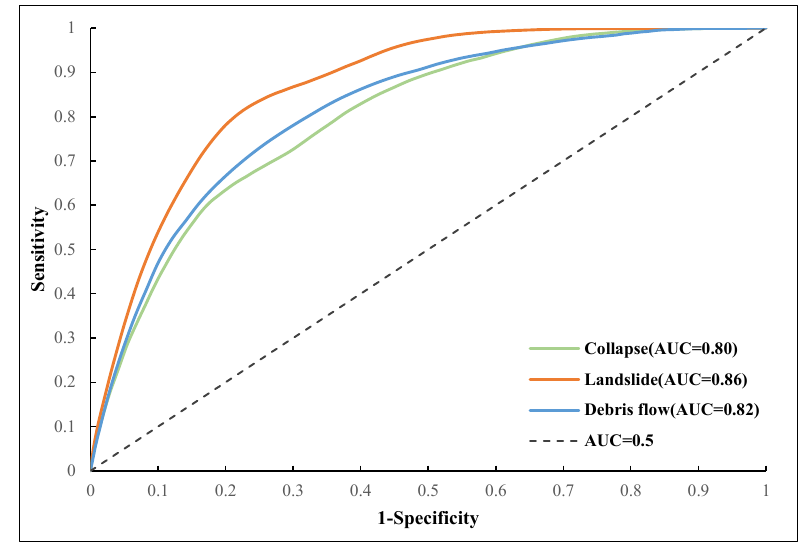
Figure 10. ROC Curve of Susceptibility to Geological Hazards.